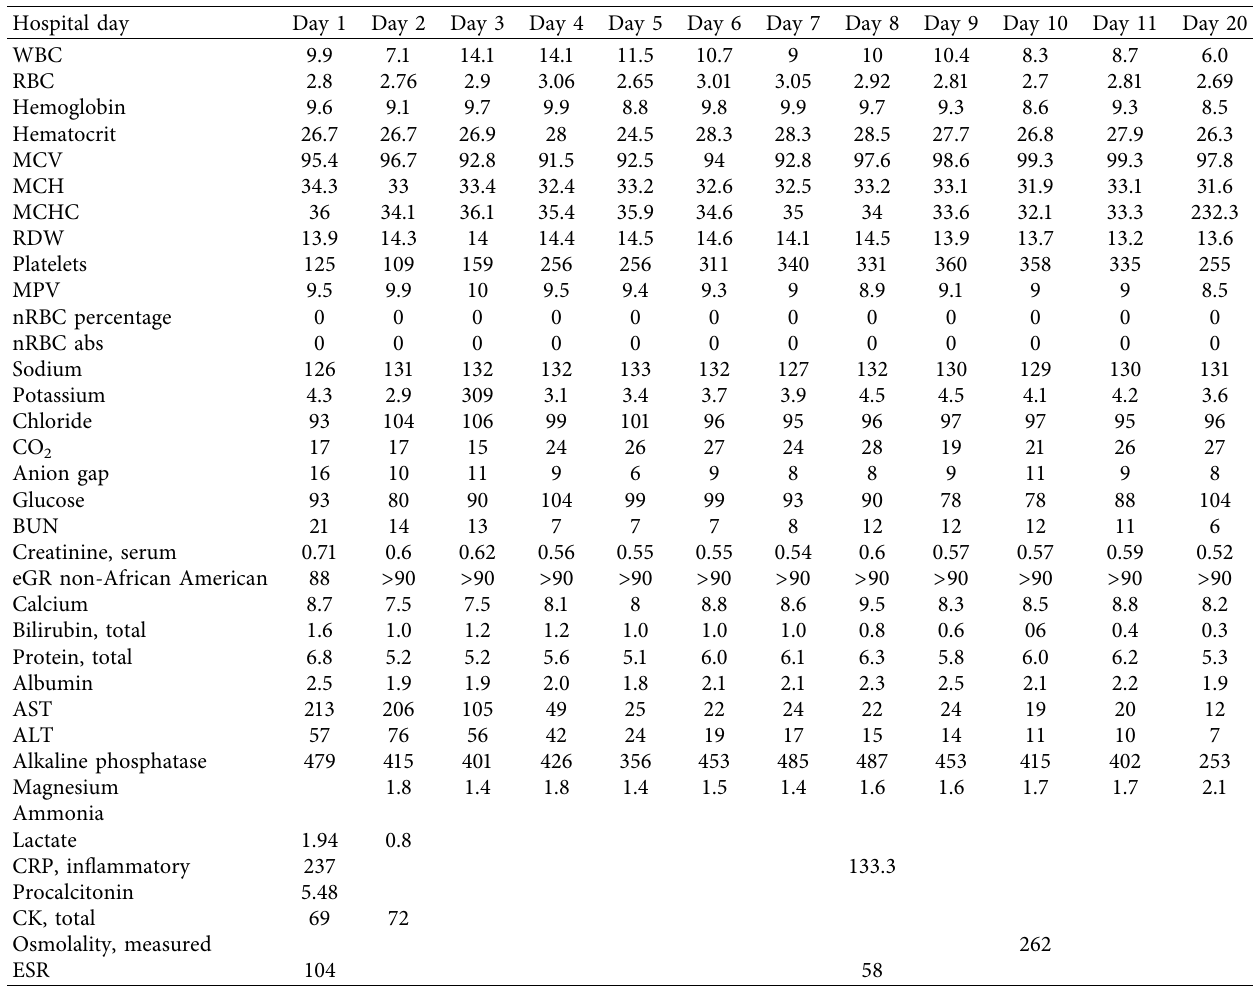
Table 1: Laboratory values from the patient’s hospital